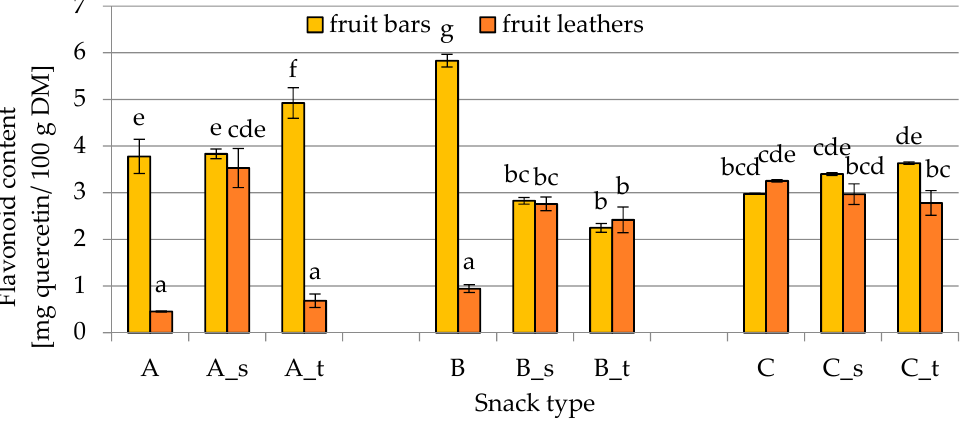
Figure 3. Flavonoid content in fruit bars and leathers (A, B, C—different composition; s—sucrose addition; t—trehalose addition) determined spectrophotometrically, as described in Section 4.2.3. Different letters above the columns indicate significant differences ( α = 0.05) between all considered samples.